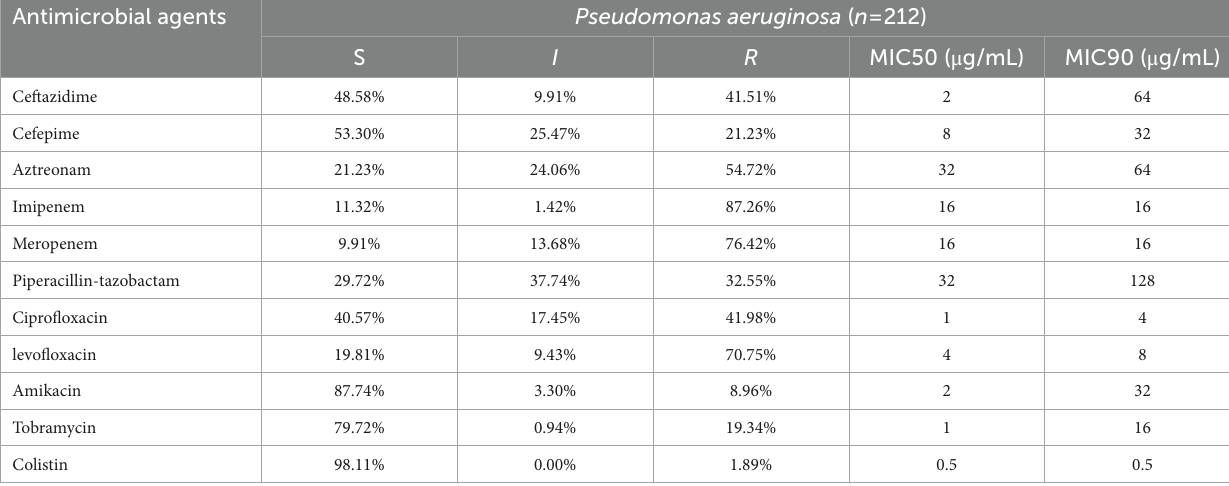
TABLE 1 Resistance rate (percentages) and minimum inhibitory concentrations (MICs) of P. aeruginosa isolates in Guangdong ( n = 212). Antimicrobial agents